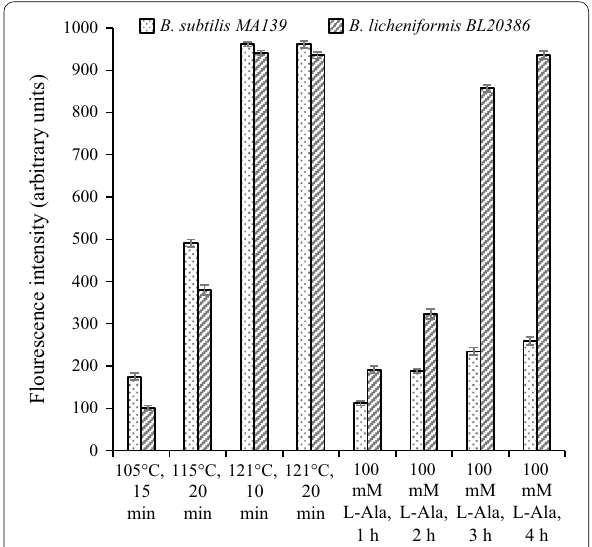
Fig. 5 Effect of different treatments on the release of DPA from endospores of B. subtilis MA139 and B . licheniformis BL20386. The value of fluorescence intensity is based the 30‑fold dilution of the spore suspensions with OD 600nm 1.0 =